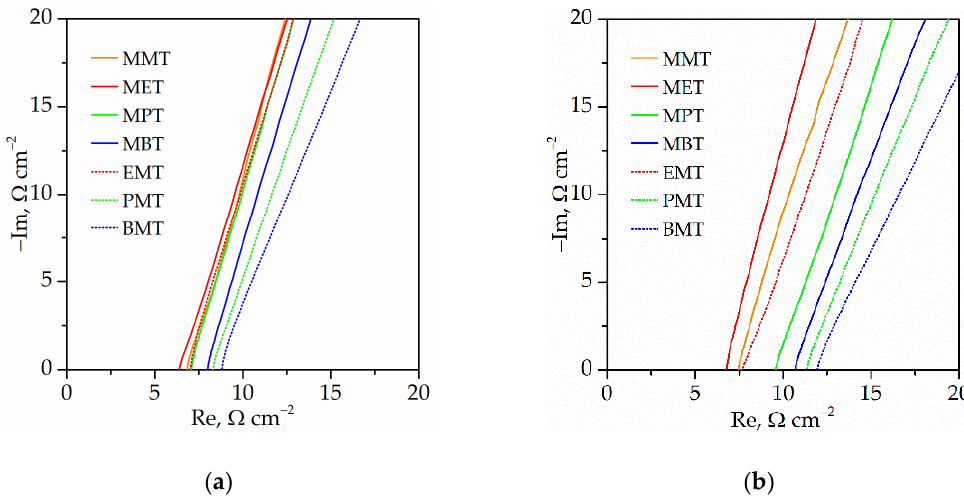
Figure 9. Nyquist plot of gel polymer electrolytes ( a ) gels with PETMP+TATT as polymer matrix ( b ) gels with PETMB+TATT as polymer matrix. Table 5. Ionic conductivity of IGs with the mixture of IL with PC as electrolyte and different polymer matrix.